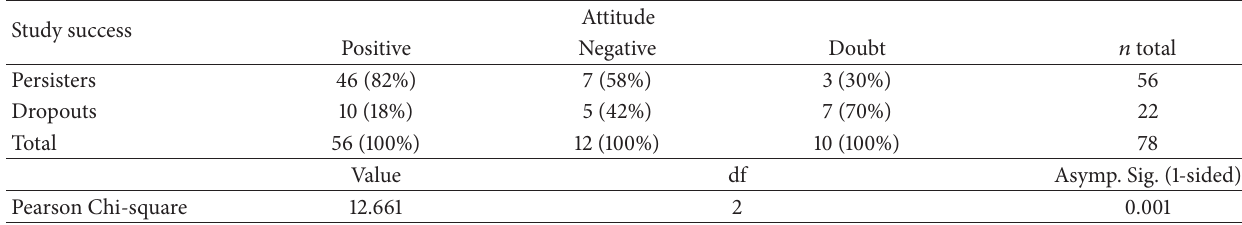
Table 7: Differences in attitude between persisters and dropouts ( 𝑛 = 78